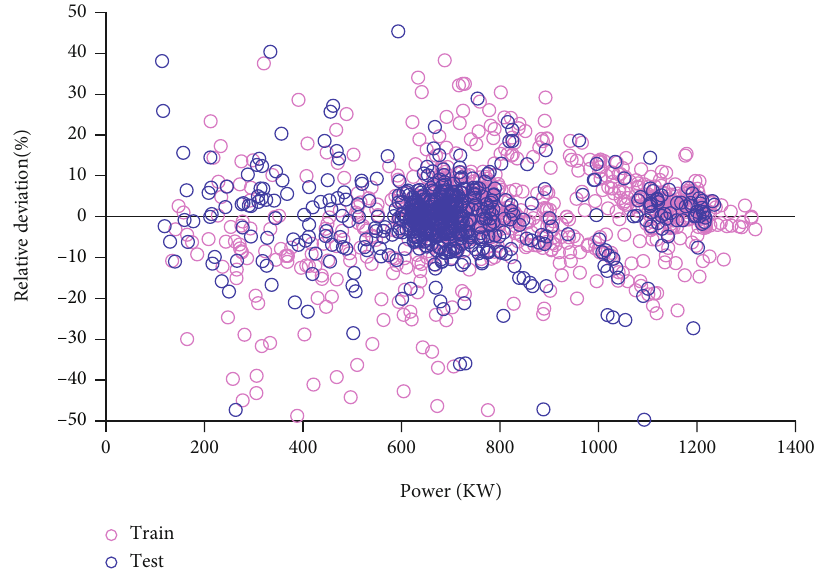
Figure 5: Relative deviation values calculated on the model to evaluate its accuracy in predicting target data. Table 1: Values of statistical parameters obtained for the proposed model.